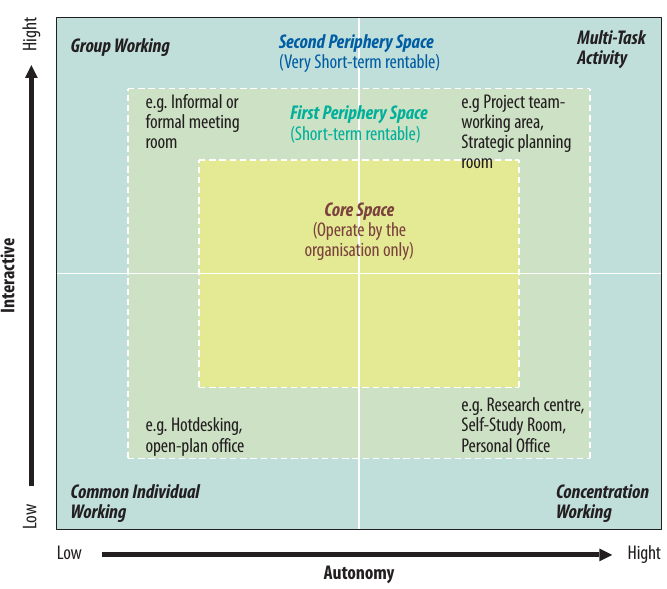
Figure 1. Combination of workspace-portfolio fl exibility